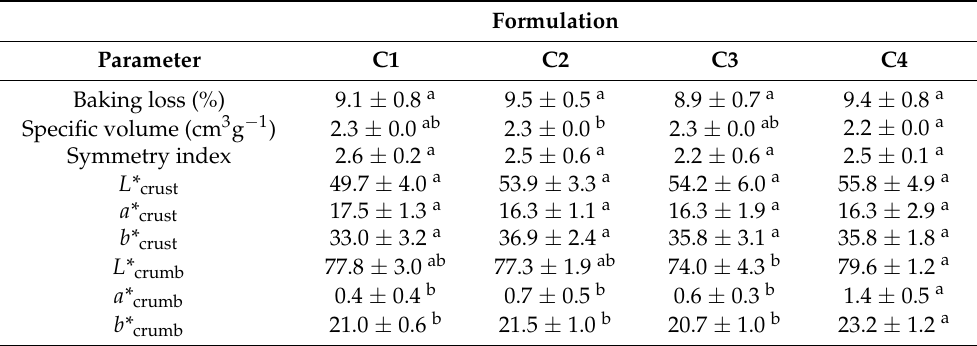
Table 3. Baking loss, specific volume, symmetry index, and color parameters of cakes made with different fats. C1, C2, and C3 contained fats E1 (35% CA and 65% CO), E2 (30% CA and 70% CO), and E3 (25% CA and 75% CO), respectively, and control (C4) contained palm oil. Formulation Parameter